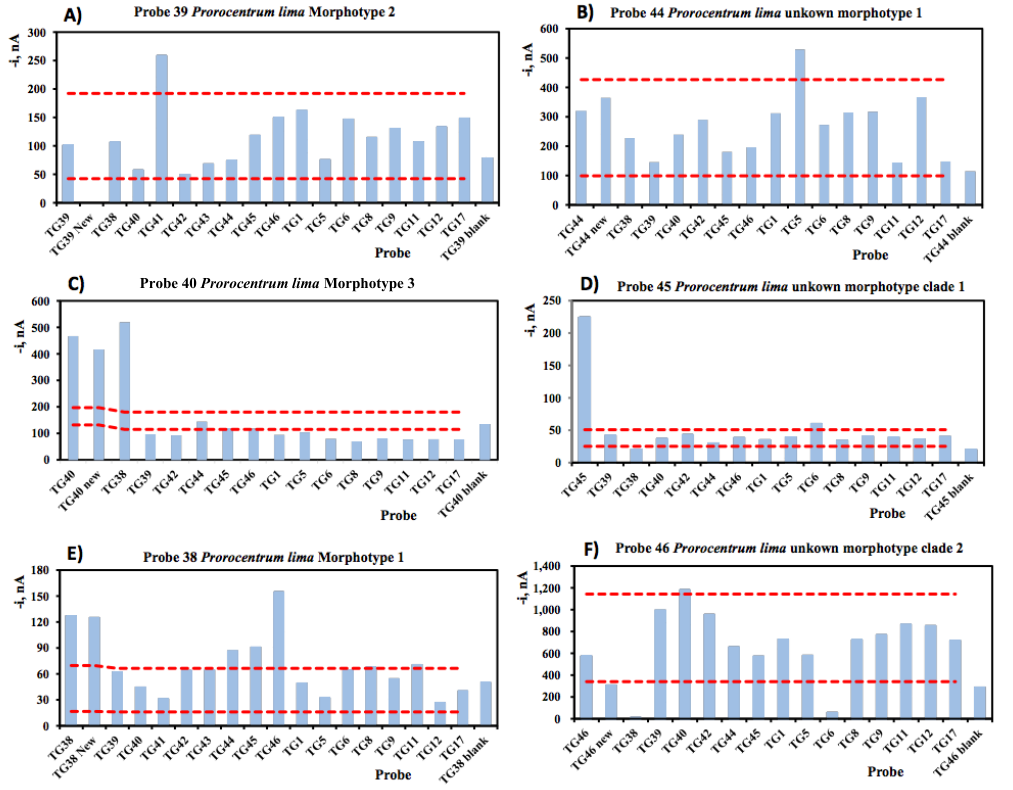
Figure 7. Comparison of cross-reactivity with synthetic targets and non-targets for Prorocentrum lima probes. +/ − 1 × SD is plotted to illustrate the signal di ff erence between non-targets and the blank (no